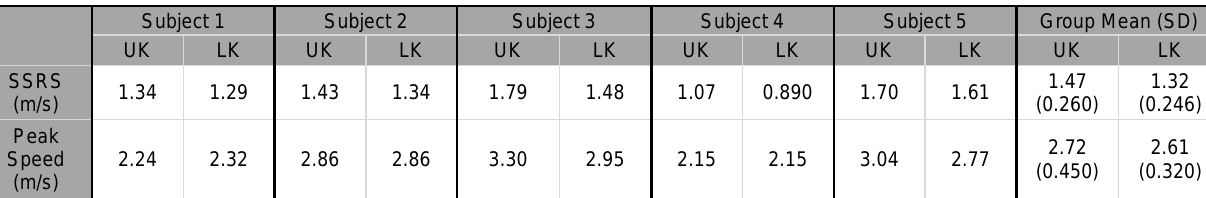
Table 5: SSRS and peak speed (maximum value of three trials) for each knee